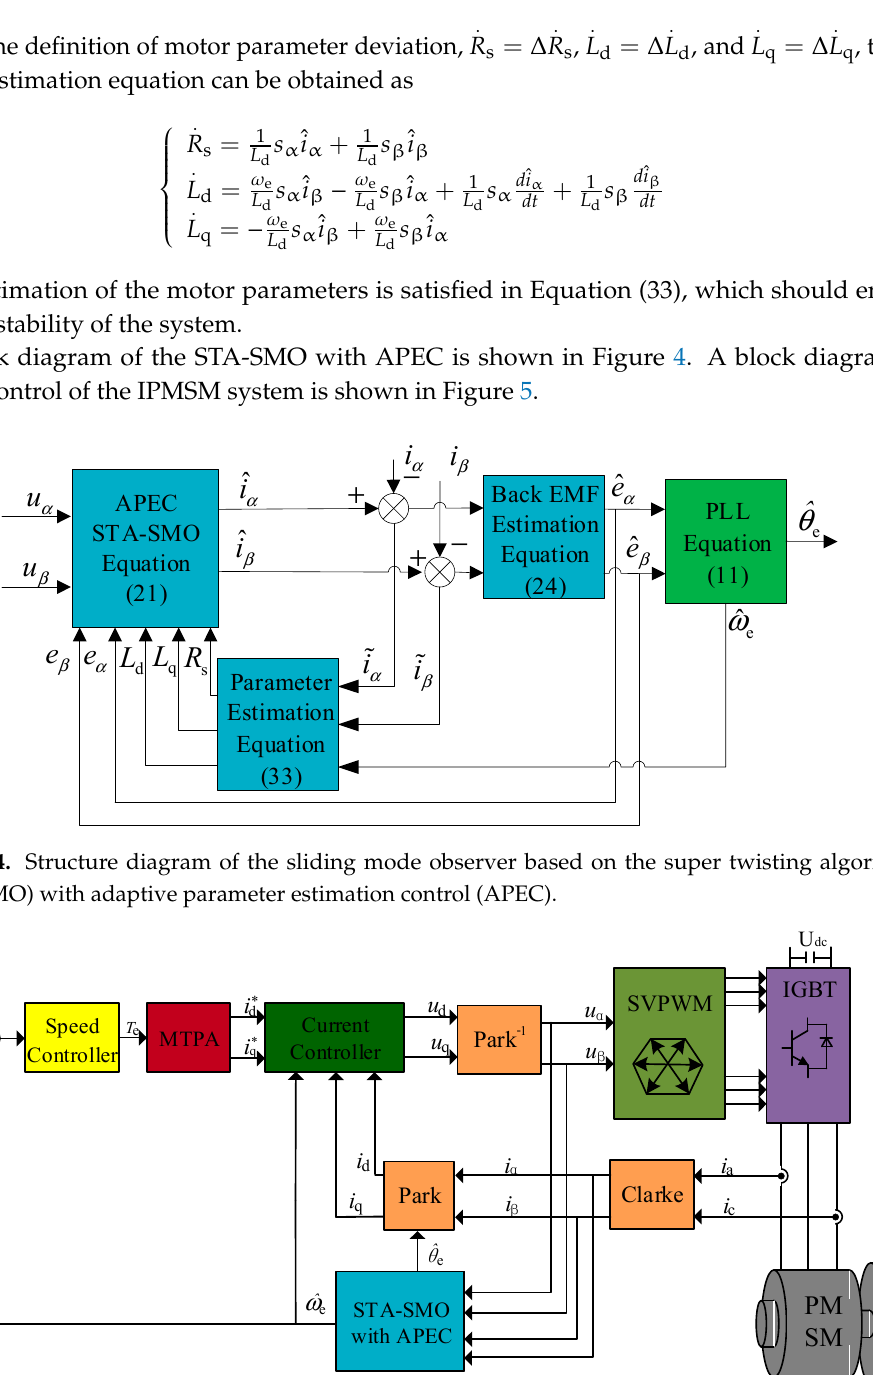
Table 1. PMSM parameters.